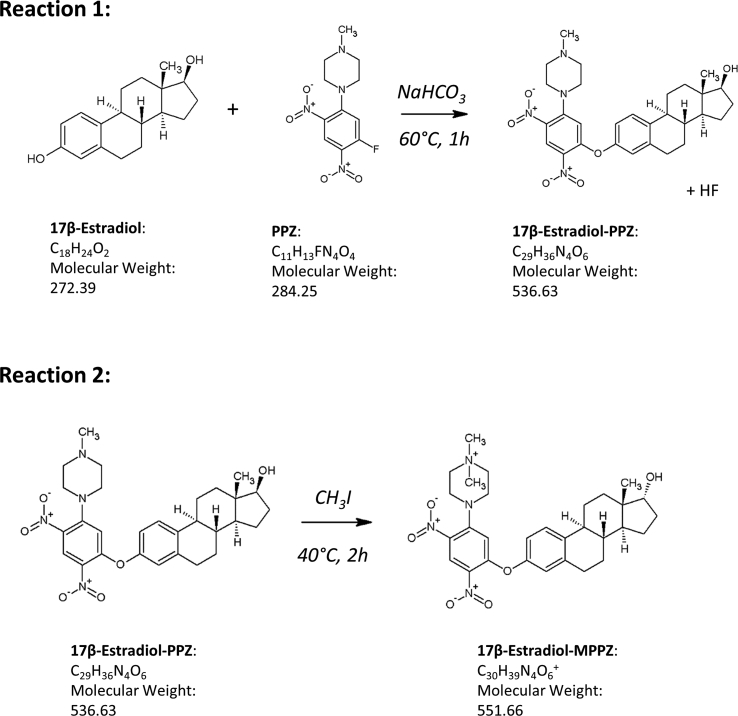
Formation of methylpiperazine (MPPZ) derivative of phenolic estrogens; showing an example of derivatization of 17β-estradiol with 1-(5-fluoro-2,4-dinitrophenyl)-4-methylpiperazine (PPZ) in the presence of sodium bicarbonate (NaHCO3) followed by reaction with methyl iodide (CH3I) to create the charged moiety.